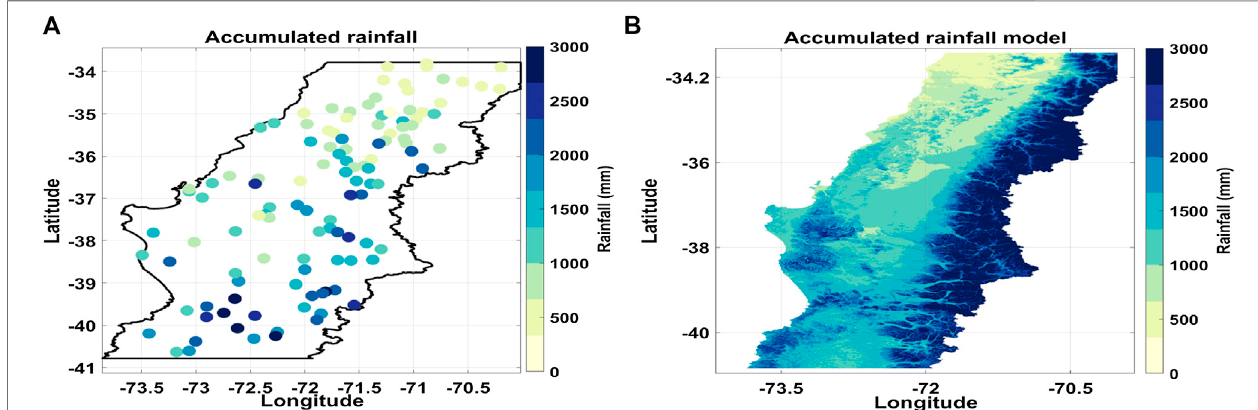
Frontiers in Earth Science |